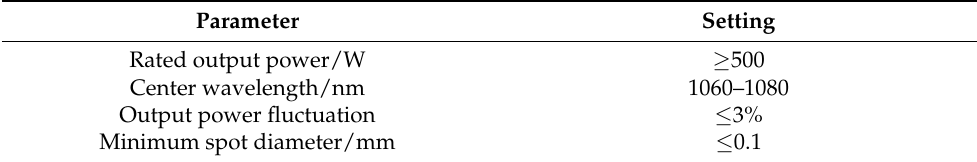
Table 1. Primary working parameters of the L-PBF platform.